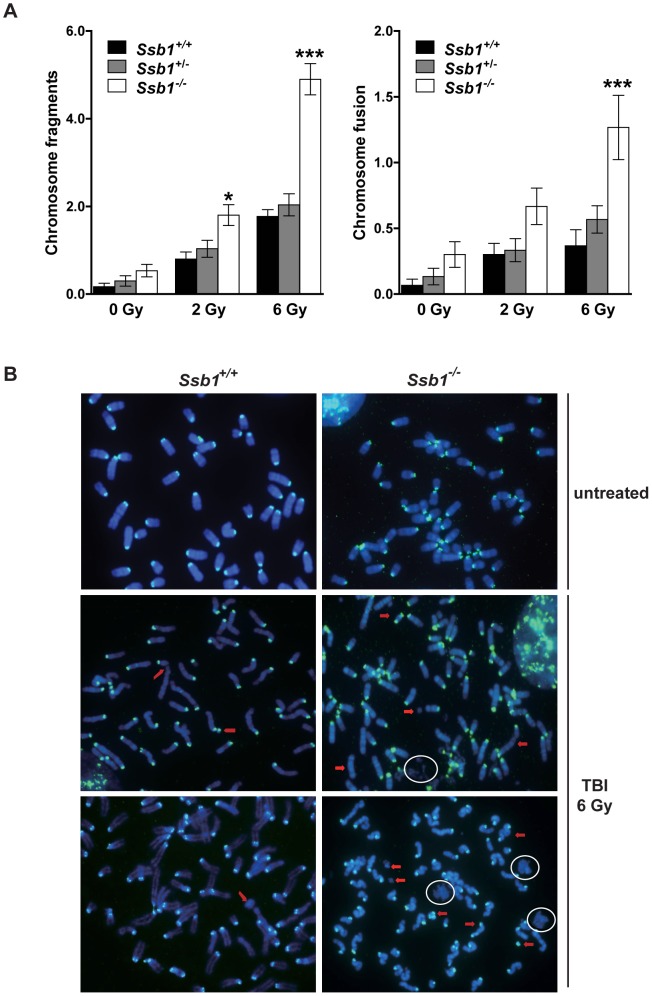
Increased genomic instability in irradiated bone marrow metaphases from total body irradiated mice.Five weeks after tamoxifen induction, nine-week-old Rosa26-CreERT2: Ssb1
+/+, Rosa26-CreERT2: Ssb1
+/− and Rosa26-CreERT2: Ssb1
−/− mice were given 2 or 6 Gy of TBI and kept for 24 h before bone marrow collection. Metaphases were prepared directly from bone marrow cells of demicolcine-treated mice for fluorescence in situ hybridization (FISH) analysis. (A) Quantification of chromosomal breakage (fragmentation and fusion) in bone marrow metaphase spreads from Rosa26-CreERT2: Ssb1
+/+, Rosa26-CreERT2: Ssb1
+/− and Rosa26-CreERT2: Ssb1
−/− mice at 24 h after 2 and 6 Gy of TBI (n = 3 mice per genotype for each condition). (B) Representative images of bone marrow metaphases from mice with indicted genotypes. Red arrows mark some of the chromosomal breakages. Note the presence of DNA debris marked with circles.